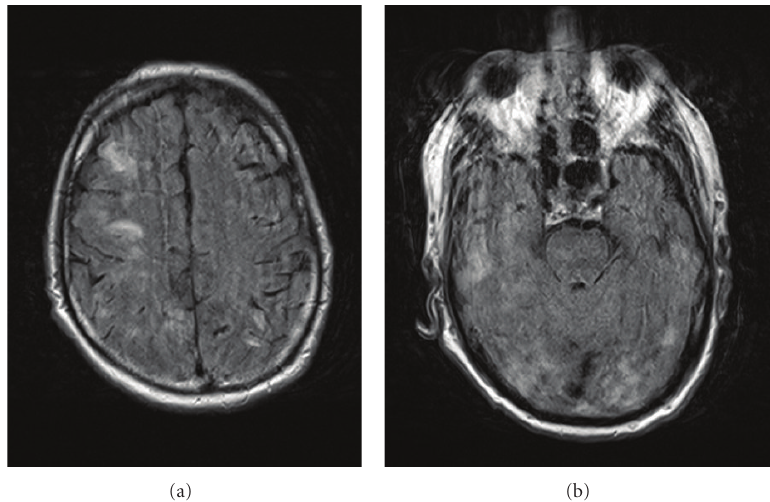
Figure 2: FLAIR AXIAL MRI images (TR 9000, TE 112) from the second admission demonstrating significant interval worsening of bilateral cortical hyperintensities throughout both cerebral hemispheres. Note the mild patient motion